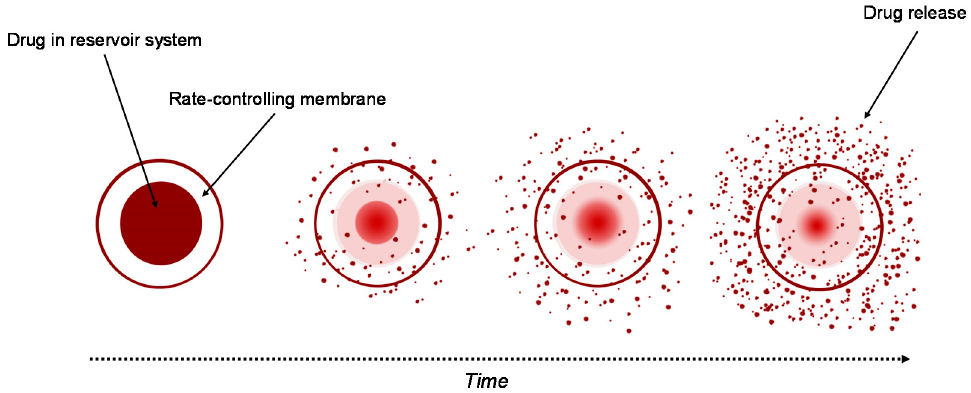
Figure 2. Drug delivery from reservoir device.